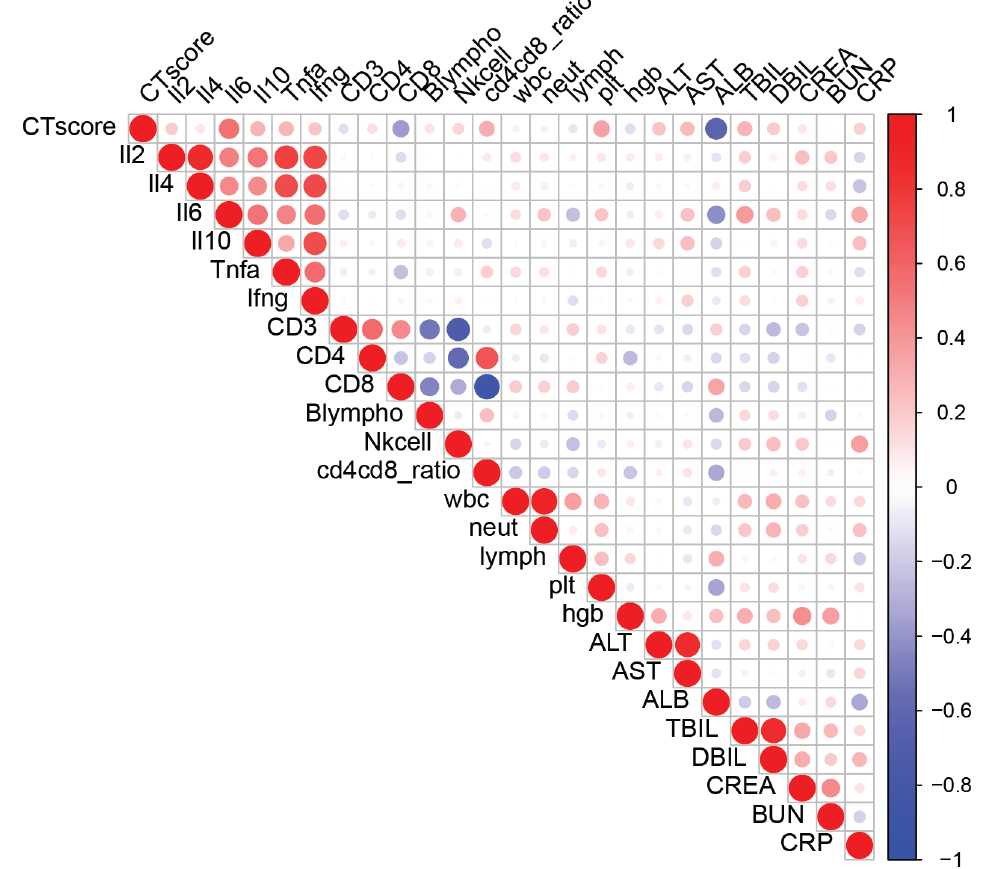
Figure 3. Lung CT image abnormalities correlate with many clinically relevant biomarkers of COVID- 19 severity. Spearman’s correlation coefficients were calculated between blood-based biomarkers measured and CT scores. Blue-to-red heat map and dot sizes identify levels of correlation. Interleukin (IL)2, IL-2; IL4, IL-4; IL6, IL-6; IL10, IL-10; Tnfa, TNF- α ; Ifng, IFN- γ ; Blympho, B lymphocytes; Nkcell, NK cells; wbc, white blood cells; neut, neutrophils; lymph, lymphocytes; plt, platelets; hgb, hemoglobin; ALT, alanine transaminase; AST, aspartate aminotransferase; ALB, albumin; TBIL, total- value bilirubin; DBIL, direct bilirubin; CREA, creatinine; BUN, blood urea nitrogen; CRP, C-reactive